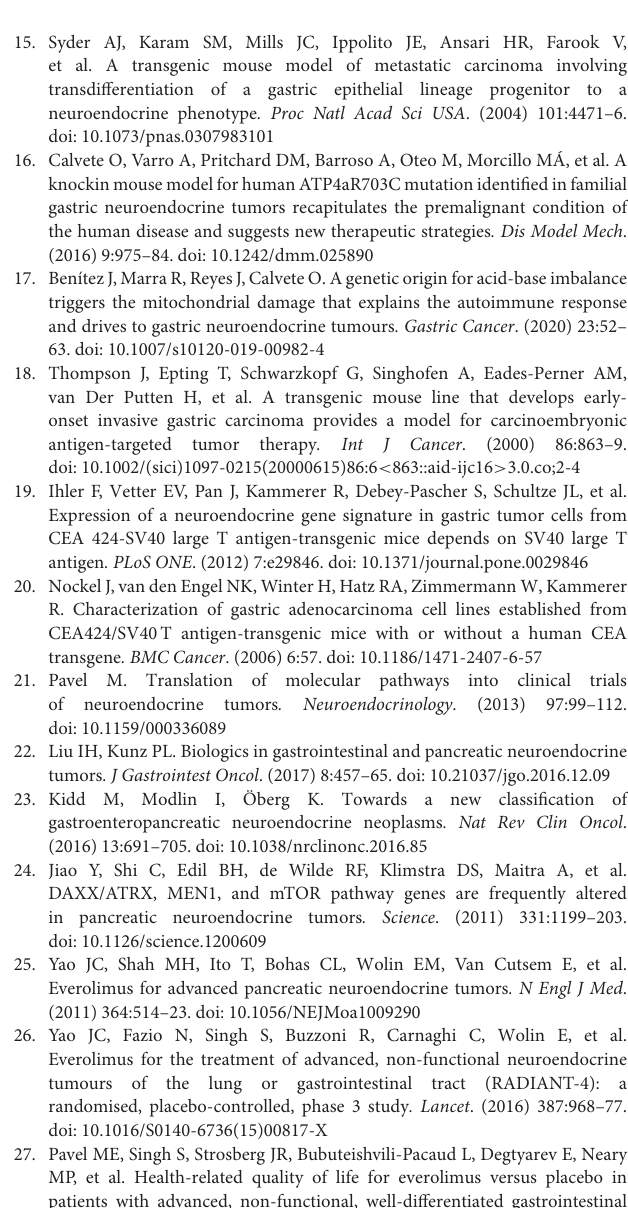
Figure S1 | Histograms of the western blot analyses shown in Firure 4A for short term treatment of 2h, 24h and 72h in the cell line 424GC, mGC3 and mGC8. Blue: control group; red: cells treated by 100nM RAD001. Figure S2 | Histograms of the western blot analyses shown in Figure 4B for RAD001 treatment in vivo. The expression of phosphorylated and total p70S6K, 4EBP1, Akt, MEK and ERK1/2, as well as the expression of SV40 TAg, Bmi1, Etvi and Nkx2.2 were evaluated in the tumor tissues from RAD001 treated mice and control mice after 48 days of treatment with RAD001 or placebo ( ∗ p < 0.05: RAD001 treated group versus control group). Figure S3 | Histograms of the western blot analyses between primary cell lines and RAD001 resistant cell lines. The expression of molecular markers was compared between the RAD001 resistant cell lines kept in 400nM RAD001 and the parental untreated cell lines. Figure S4 | The mice weight at the beginning of the treatment. There was no significant difference of the mice weight between the control group and RAD001 treated group in both the first experiment and the second